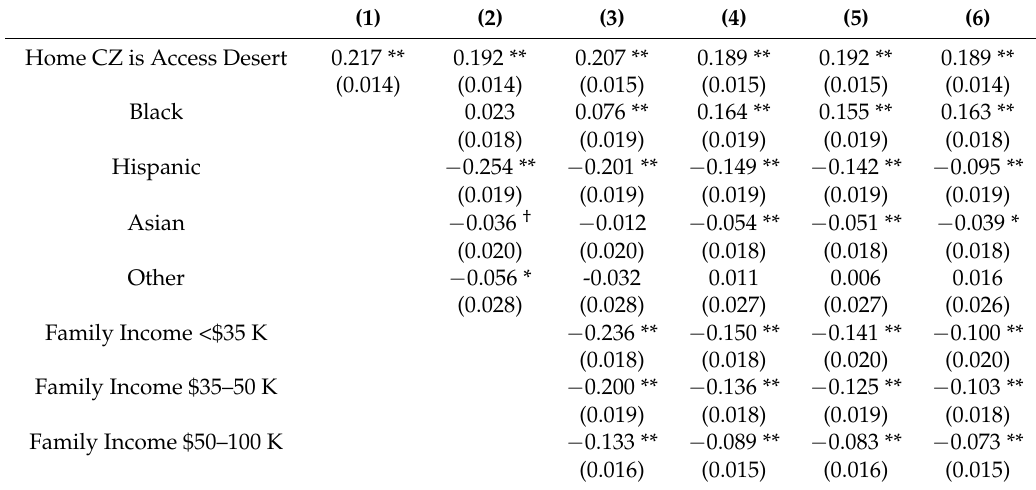
Table A1. Relationship between living in an access desert and applying to a college outside of home commuting